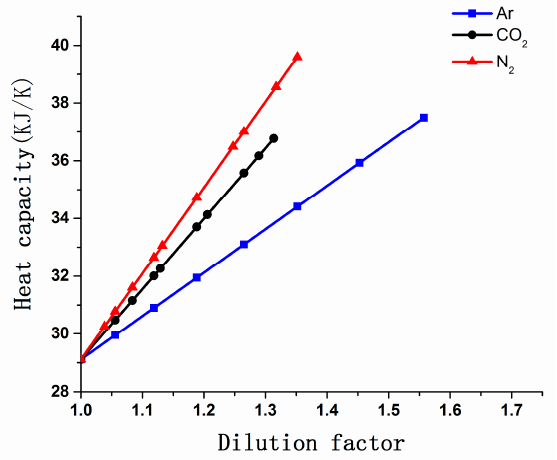
Figure 2. Variation in the mixture heat capacity vs. the DF of CO 2 , N 2 , and Ar.